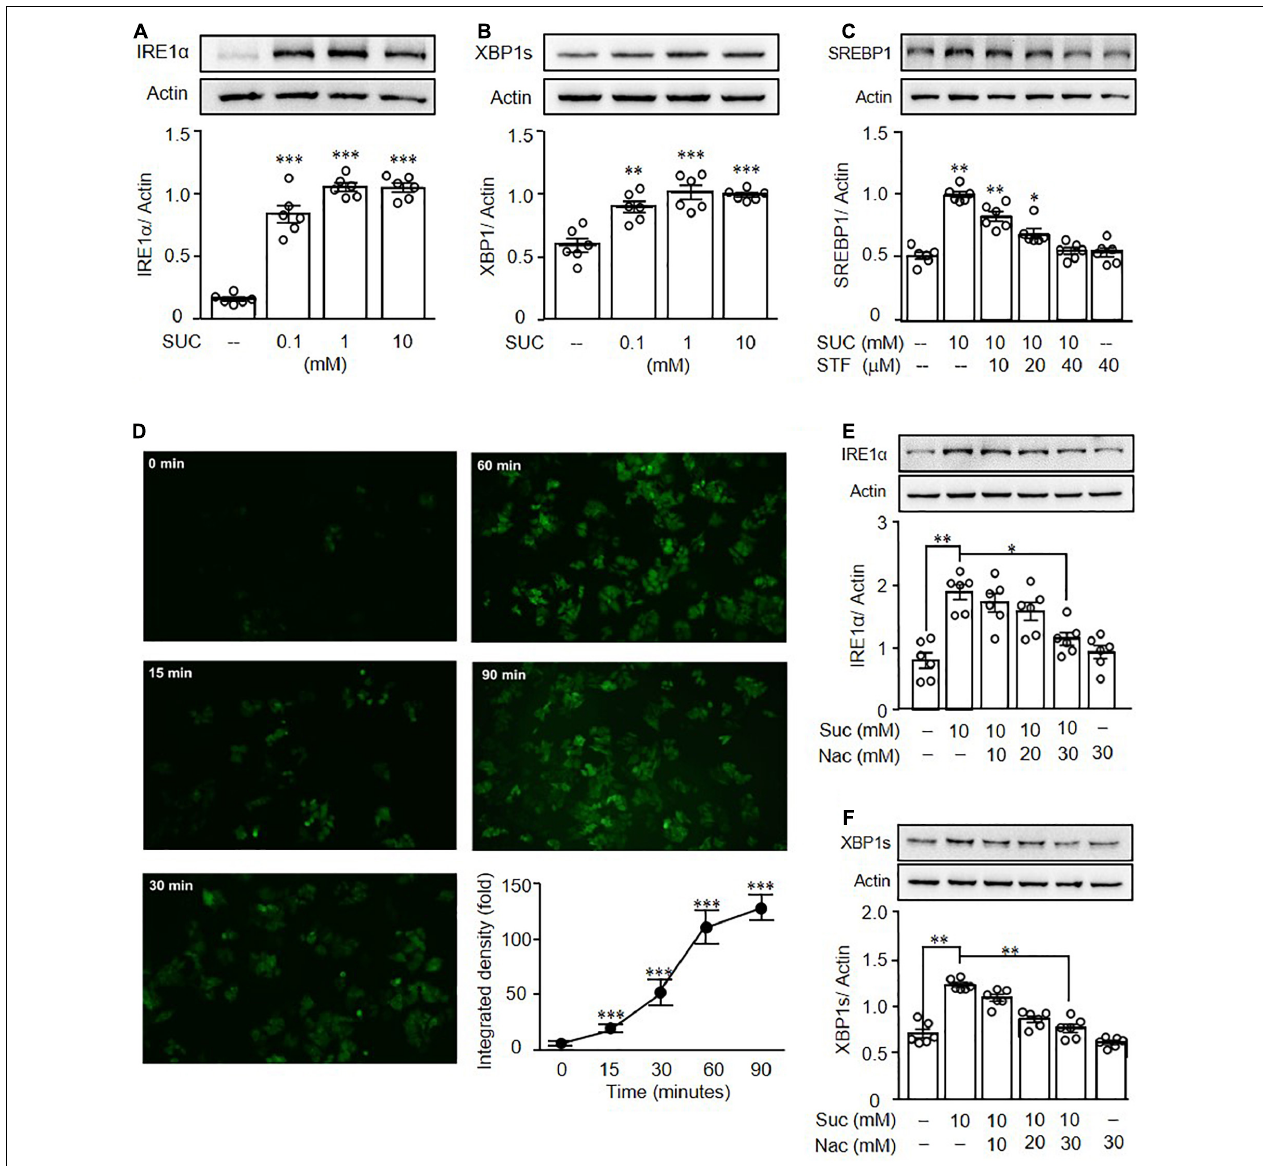
FIGURE 5 | Sucralose increased reactive oxygen species to induce endoplasmic reticulum stress in HepG2 cells. HepG2 cells were treated with indicated concentrations of sucralose (SUC) for 16 h to analyze the expressions of IRE1 α (A) and XBP1s (B) by Western blots. The cells were pretreated with STF083010 (IRE1 inhibitor) at indicated doses for 30 min, and then treated with 10 mM sucralose for another 24 h for the determination of SREBP1 by Western blots (C) . HepG2 cells were treated with 10 mM sucralose and the reactive oxygen species production was determined by DCFDA staining at indicated times. The fluorescence intensity was analyzed by ImageJ software (100X) (D) . Cells were pretreated with N-acetylcysteine (NAC) at indicated doses for 30 min, and then treated with 10 mM sucralose for another 16 h to determine IRE1 α (E) and XBP1s (F) expressions by Western blots. Data are the mean ± SEM ( n = 6 for each group) ∗ p < 0.05, ∗∗ p < 0.01, ∗∗∗ p < 0.001 as compared with indicated